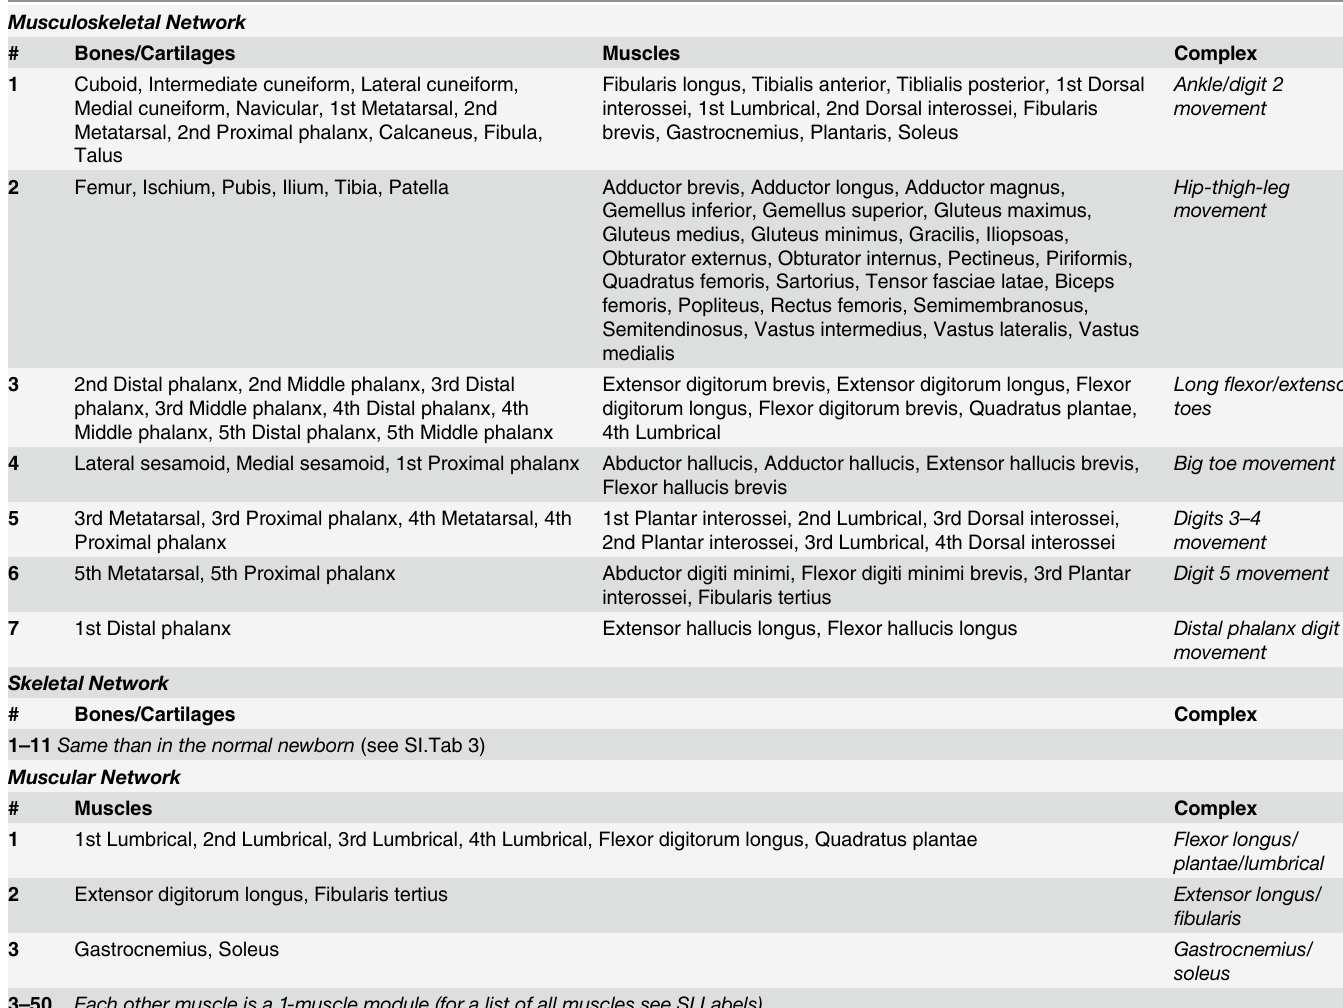
Table 5. Phenotypic modules in the left lower limb of the T18